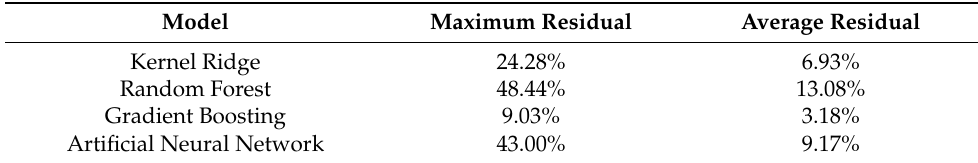
Table 6. Machine learning models accuracy for the test data set.